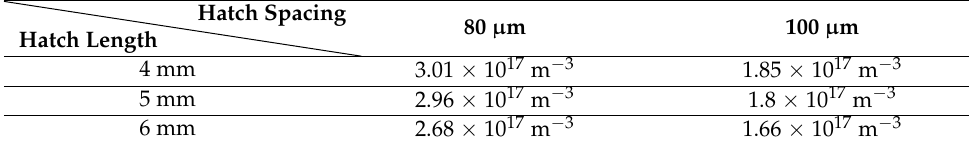
Table 2. Mean number density in control volume.